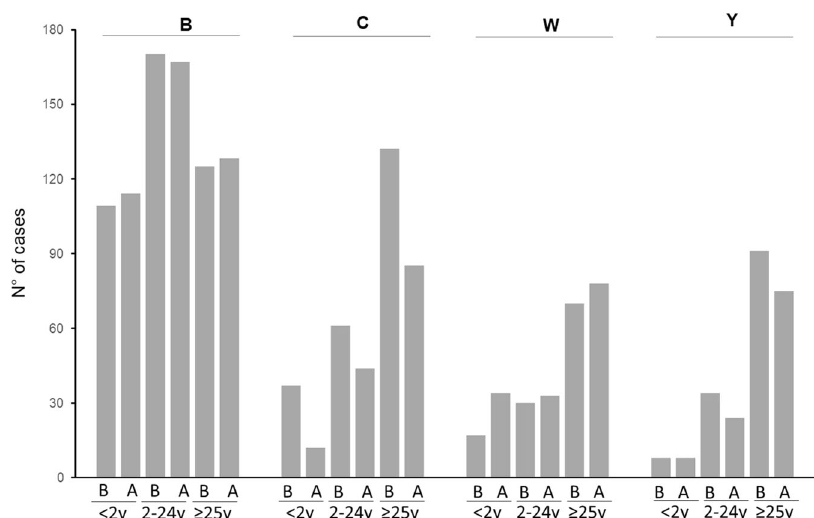
Fig. 2 Distribution of cases of IMD per serogroup and per age group during the period 2016 – 2019. Three age groups are shown (<2 years, 2 – 24 years and ≥ 25 years). Data per period before compulsory vaccination ( B : 2016 – 2017) and after ( A : 2018 – 2019) are Fig. 5. The analysis of this tree showed that 286 of the 290 CC11